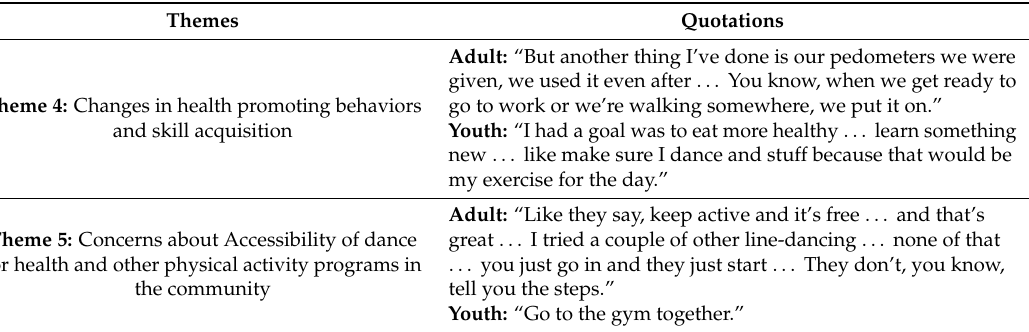
Table 4. Themes and Quotations: (N =